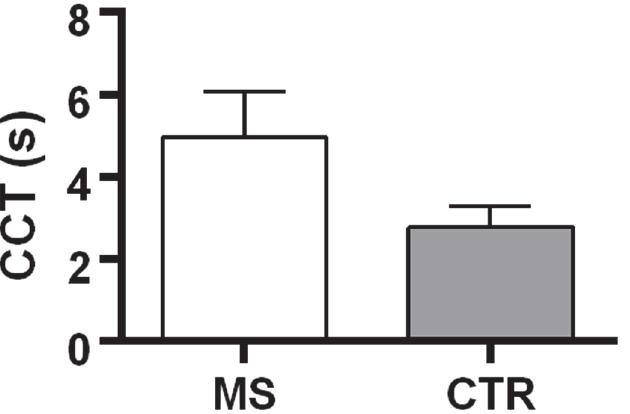
Fig 3. The figure represents the distribution (median and IQR) of the CCT measured in seconds. The control group showed significant lower CCT. The difference between the CCT mean in MS and CTR was 2.09 s with a confidence interval of 95% [1.77 s: 2.41